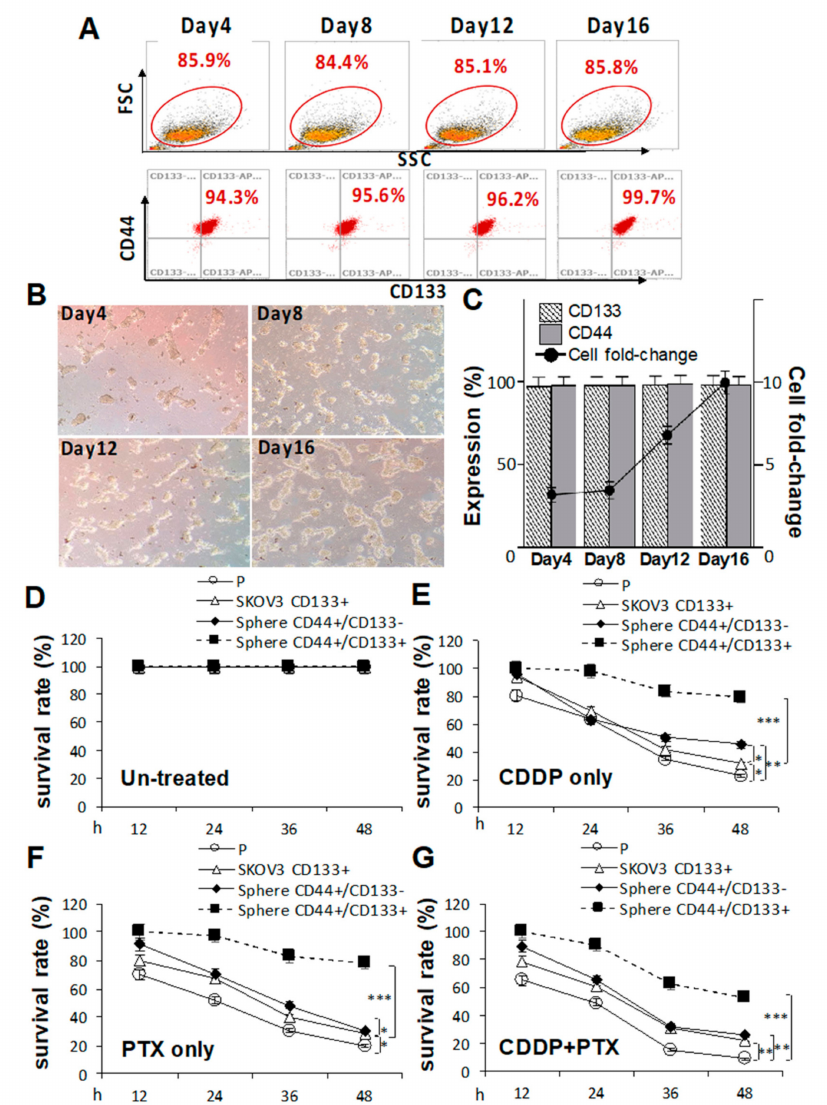
Figure 3. Cluster of di ff erentiation 133 (CD133) expression is essential for sustaining cancer stem cell (CSC) traits and drug-resistance capacities. E ff ects of CD133 transduction and overexpression in ( A ) sphere-forming ability in ( C ) and morphological changes in CD133 non-expressing SKOV3 cells following 4, 8, 12, and 16 days of sphere cell induction in ( B ). E ff ects of CD133 overexpression with 1.2 µ M cisplatin (CDDP) alone, 1.4 nM paclitaxel (PTX) alone, or their combination were evaluated by cell viabilityassaysamonguntreatedin( D ),CDDP-treatedin( E ),PTX-treatedin( F ),andCDDP + PTX-treated experiments. * p < 0.05; ** p < 0.01; *** p <